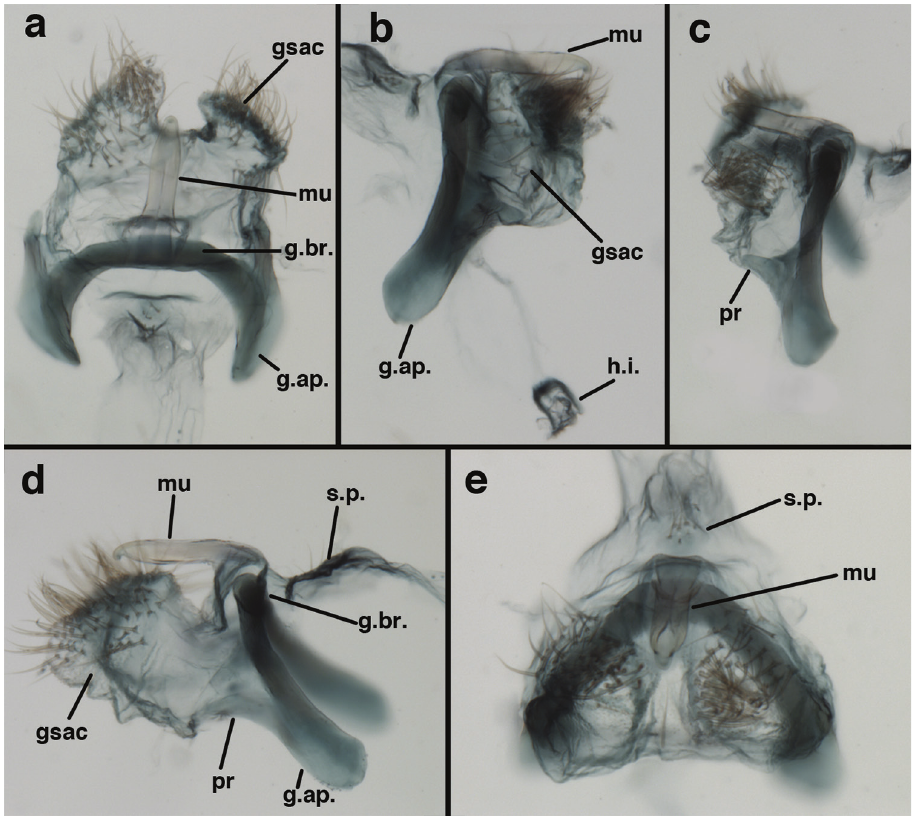
Figure 60. Ungla martinsi Sosa: Male genitalia, ( a ) gonarcal complex, dorsal, with gonosaccus expanded ( b ) gonarcus, lateral, with gonosaccus partially expanded ( c ) gonarcus, lateral, gonosaccus partially ex- panded ( d ) gonarcus, lateral, gonosaccus expanded ( e ) gonarcus, frontal, gonosaccus partially expanded. gsac gonosaccus g.ap. gonarcal apodeme g.br. gonarcal bridge h.i. hypandrium internum mu me- diuncus pr unarticulated process on frontal margin of gonarcal apodeme s.p. setose subanal plate (all: Venezuela, Aragua,